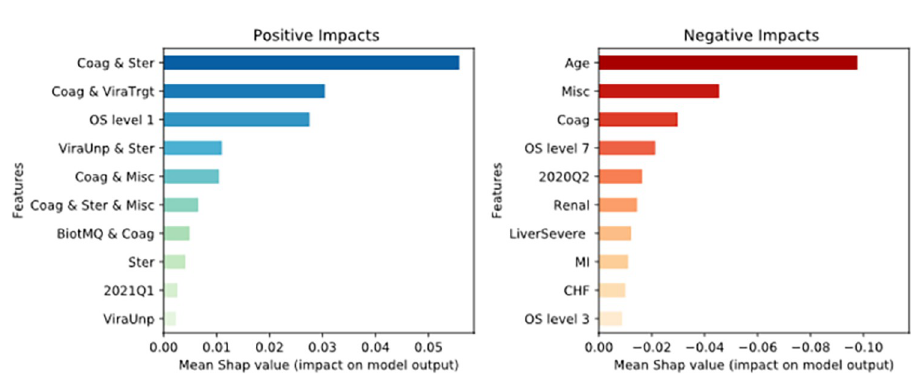
Fig 6. Top 10 features with the highest impact on final model